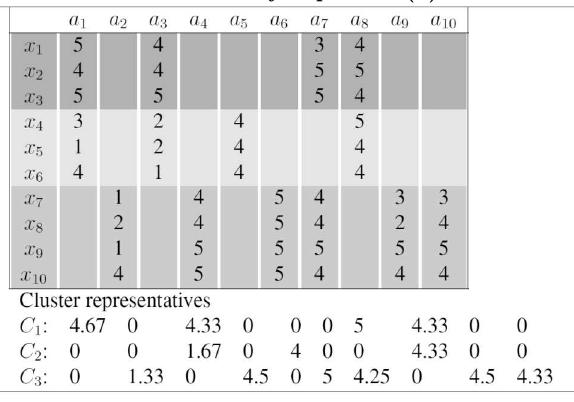
Calculation of a representative vector of clusters in the approach described by Equation